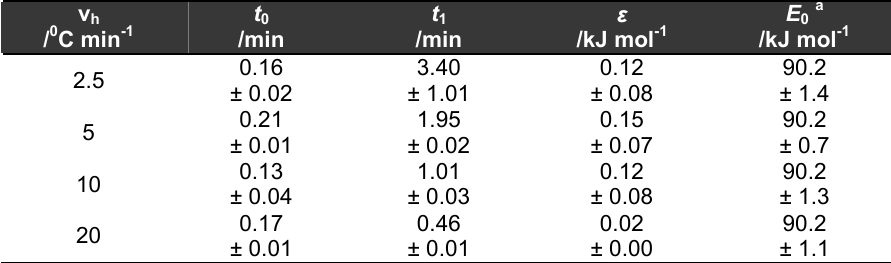
Table 4 – The influence of the heating rate (v h ) on the values of the fitting coefficients (t 0 , t 1 and ε ) and the threshold activation energy (E 0 ), for the non-isothermal reduction pro- cess of nickel oxide samples prepared by the gel-combustion method, under hydrogen